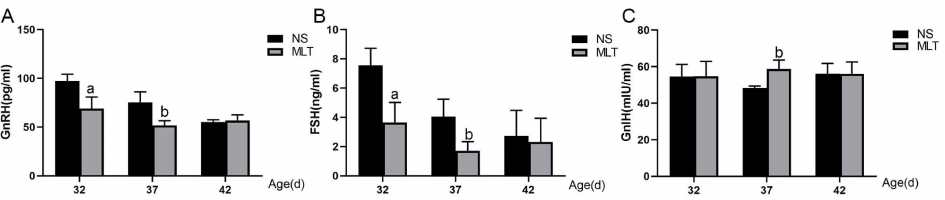
Figure 4. Melatonin’s effects on female mice’s serum GnRH, FSH and GnIH hormone levels (n = 13). ( A ) Melatonin decreased serum GnRH concentration. ( B ) Melatonin decreased serum FSH concentra- tion. ( C ) Melatonin increased serum GnIH concentration. a: p < 0.05 vs. 32 dNS; b: p < 0.05 vs. 37 dNS; 32 d, 32 days; 37 d, 37 days; 42 d, 42 days; NS, normal saline; MLT,